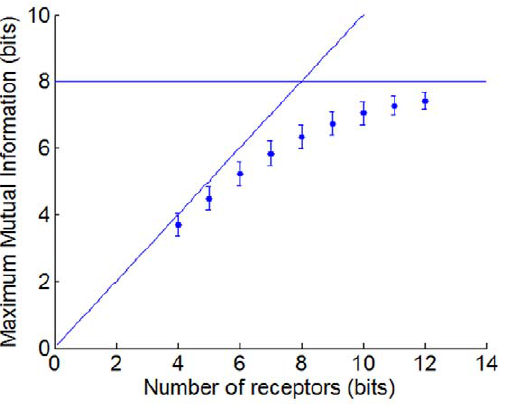
Figure 5. Maximum Mutual Information across a number of receptors. The coding capacity increases for larger ensembles of receptors. However, the MI is bound by the maximum entropy of the discrimination task, in this case 256 stimuli (8 bits).